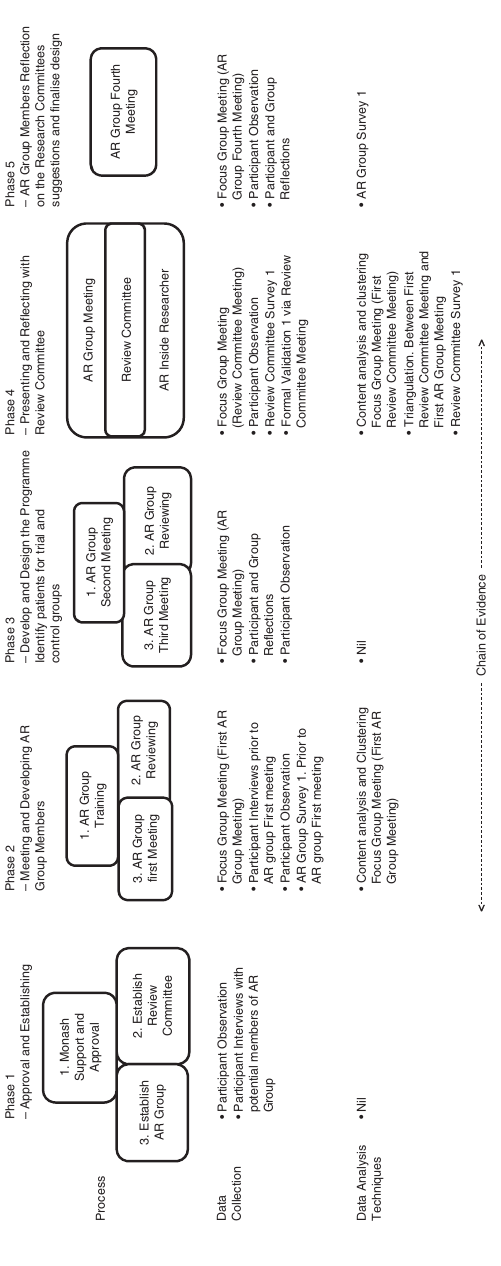
Figure 1. Design stage: three to four months